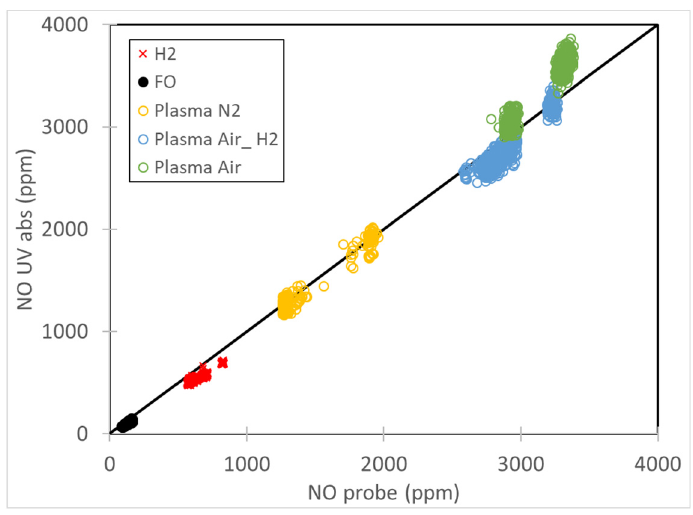
Figure 9. NO UV absorption vs. NO probe measurements for different heating methods of the process air.